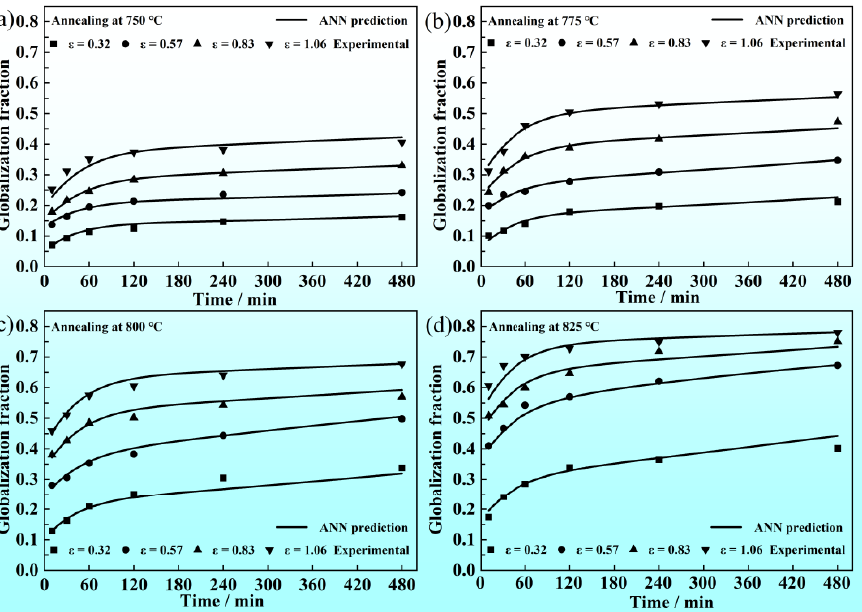
Figure 14. Static globularization kinetic curves predicted by GA/BP-ANN at different temperatures: ( a ) 750 °C; ( b ) 775 °C; ( c ) 800 °C; ( d ) 825 °C.